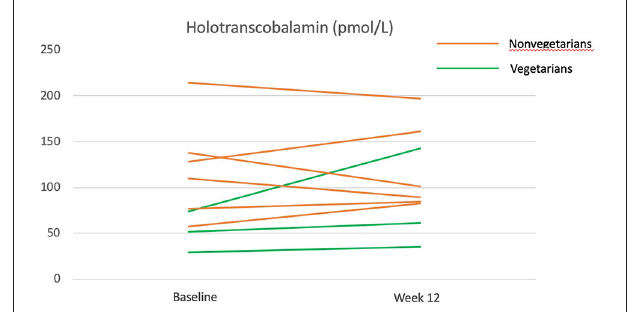
FIGURE 4 | Holotranscobalamine before and after the 12-week diet intervention. Green lines represent participants who were vegetarians at baseline. Orange lines represent participants who were nonvegetarians at